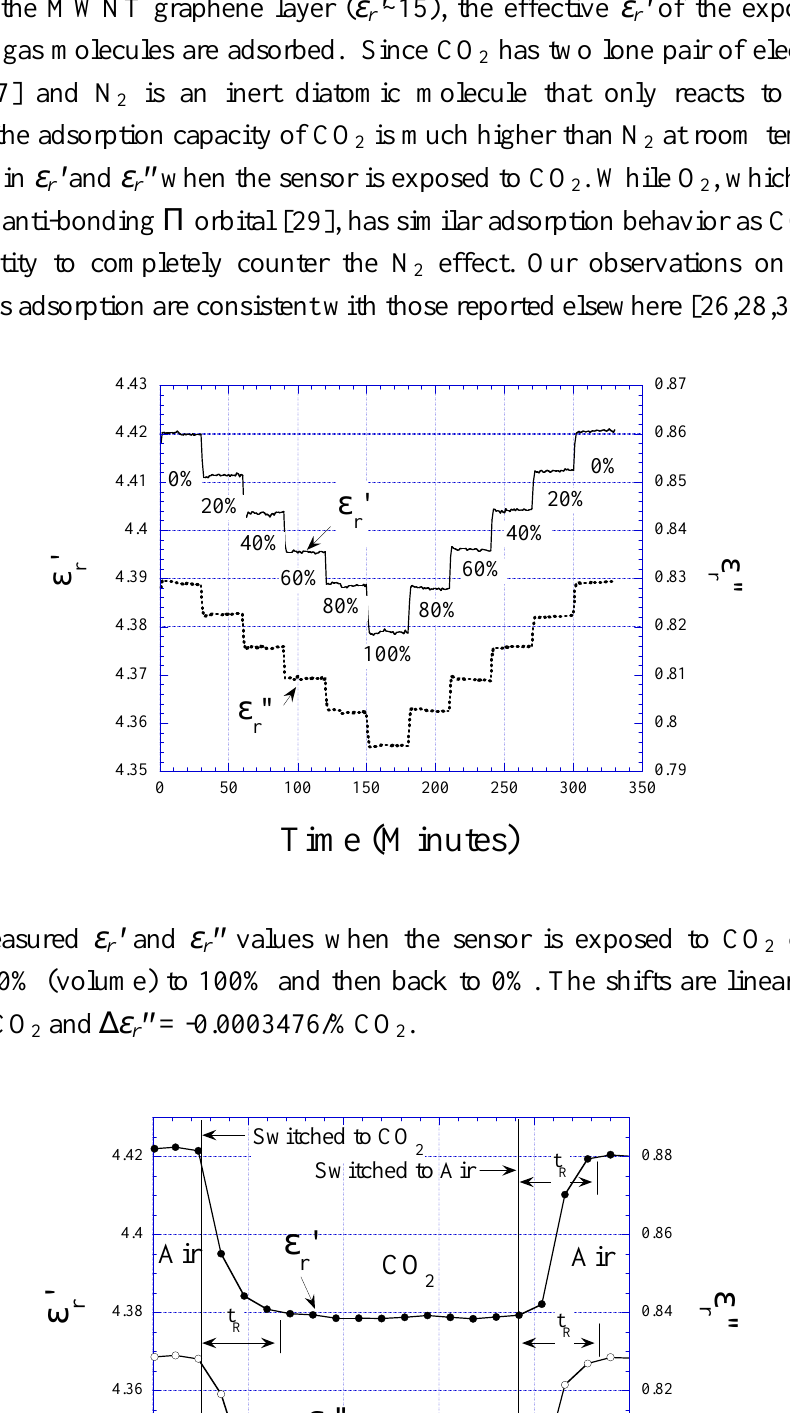
' and ε " when the gas is switched from air to CO r r , can be determined from the figure as less than 45 R